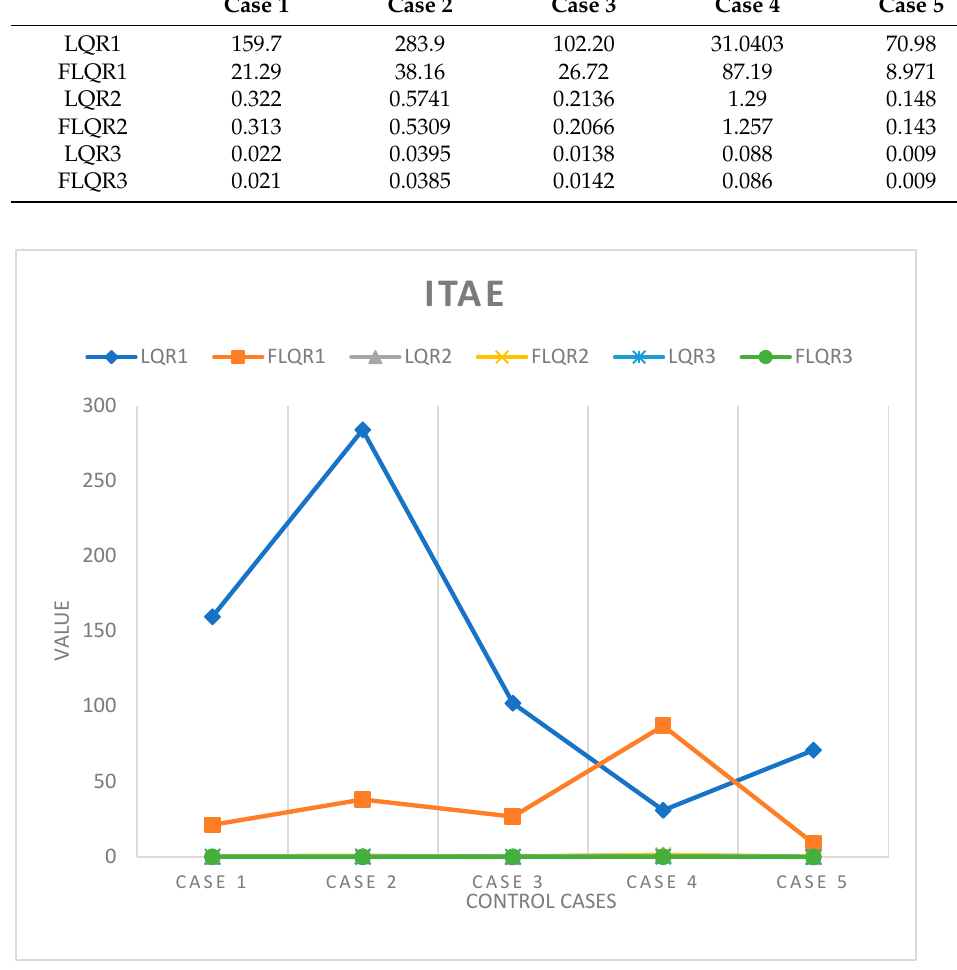
Figure 17. ITAE comparison.